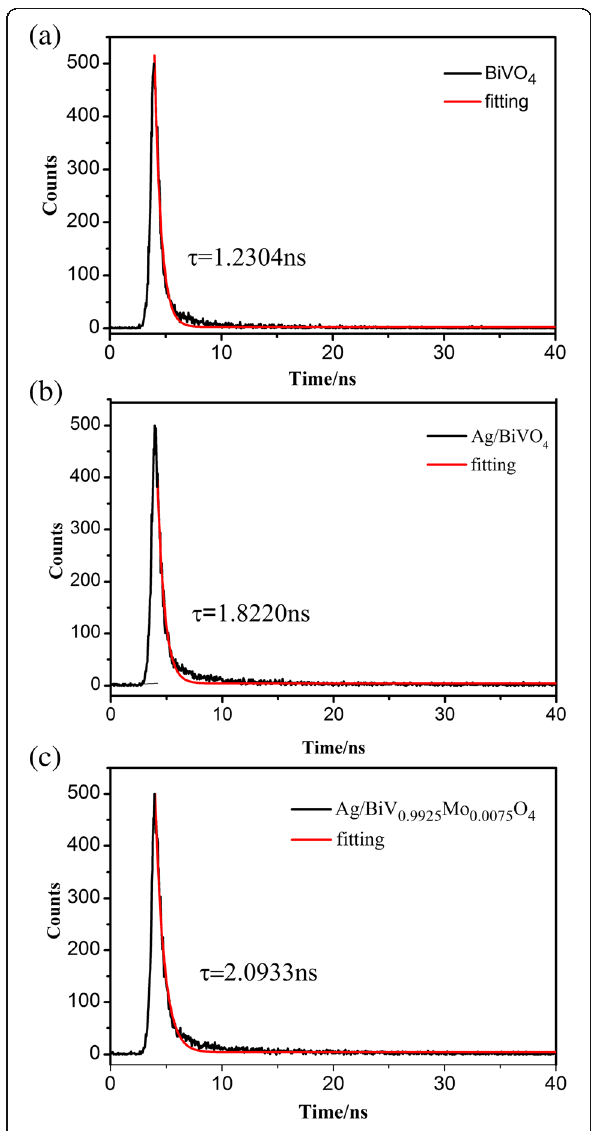
Fig. 10 Ns-level time-resolved fluorescence decay curves of as-prepared a BiVO 4 , b Ag/BiVO 4 , and c Ag/BiV 0.9925 Mo 0.0075 O 4 composite